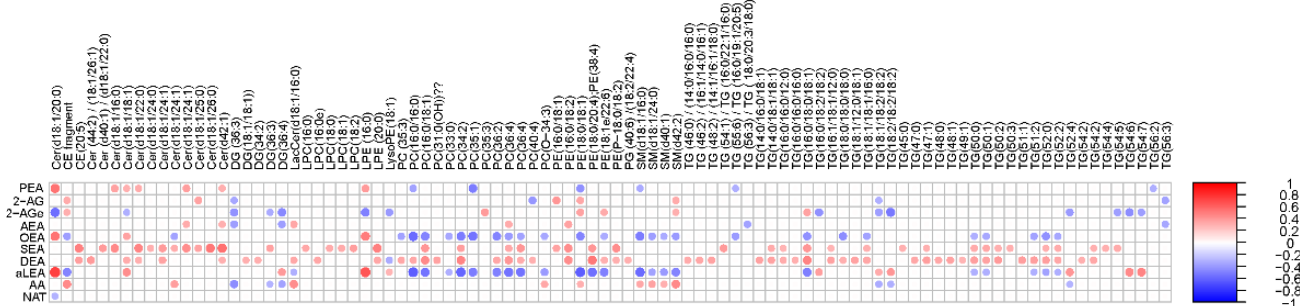
Figure 5. Association of the lipidome and ECs in the in vitro colon simulator. Spearman correlation coefficients illustrated by heat map. coefficients illustrated by heat